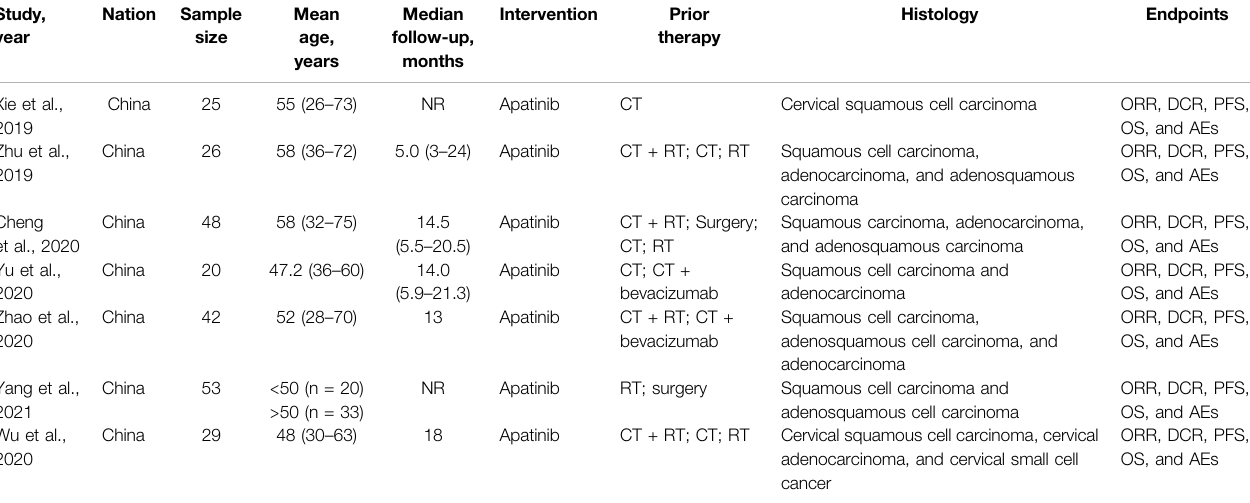
TABLE 1 | Characteristics of the studies included in the meta-analysis.